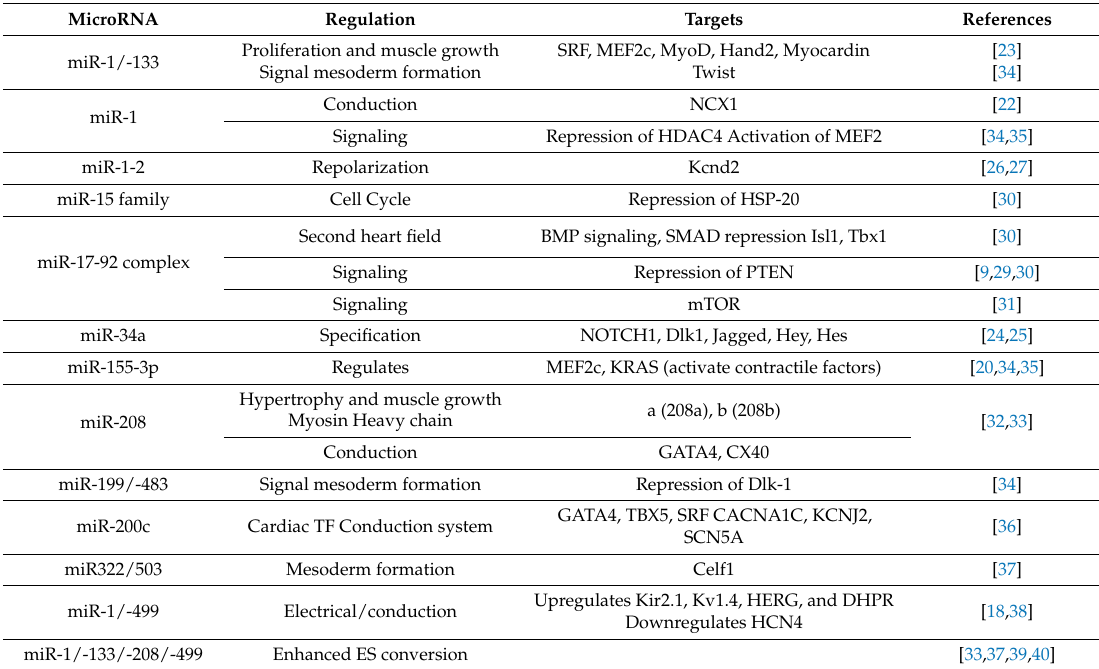
Table 1. Principal miRNA during Heart development and Embryonic Stem cell